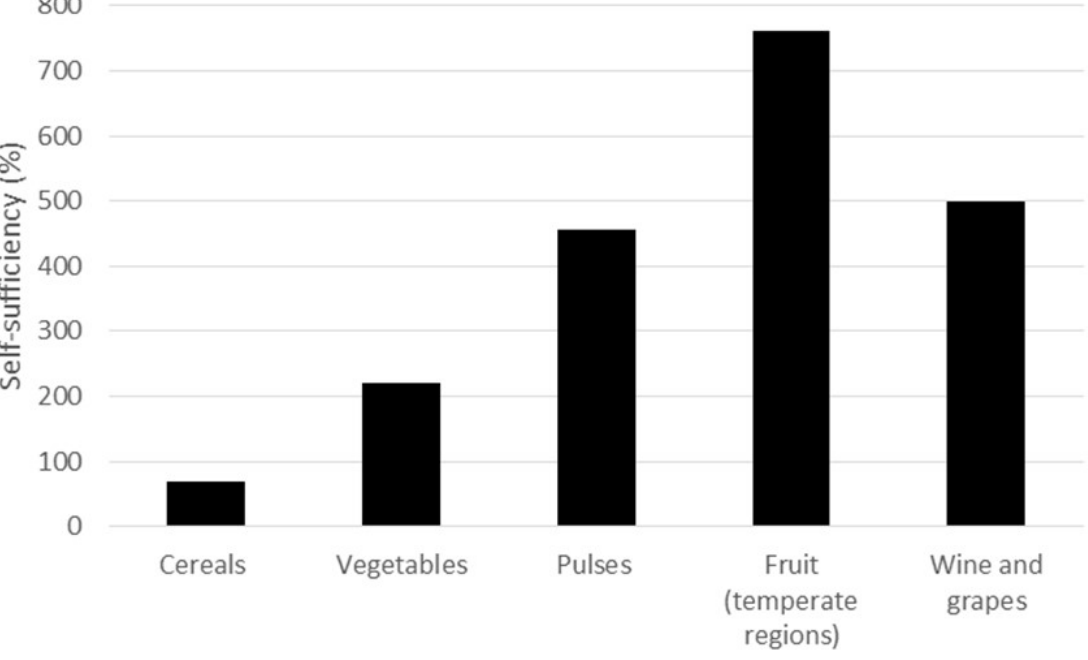
Figure 6. Current food self-sufficiency achieved by cereals, vegetables, pulses, fruit from temperate regions, and wine and grapes in the foodshed area. More information on the food groups and calculations is given in Table S5 in the Supplementary Material.